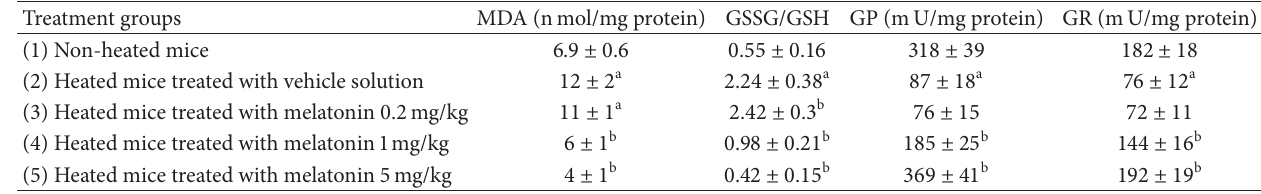
Table 4: Effects of heat exposure on hypothalamic levels of various parameters in different groups of mice. Treatment